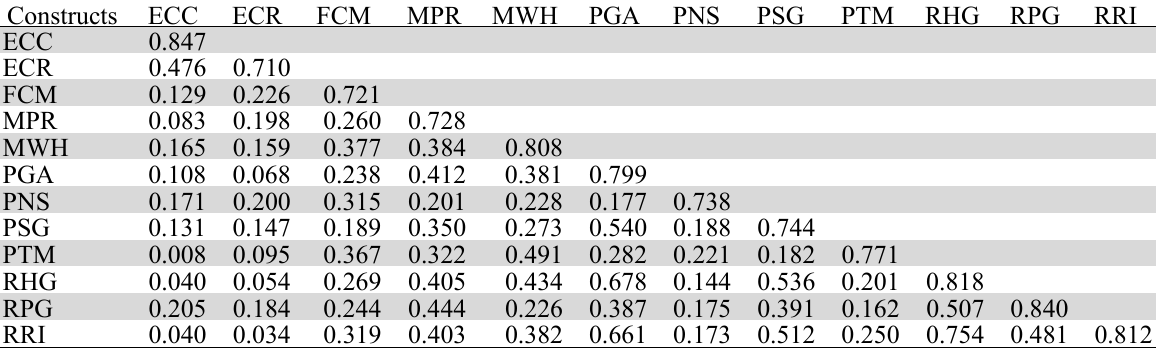
Fornell-Larcker Criterion